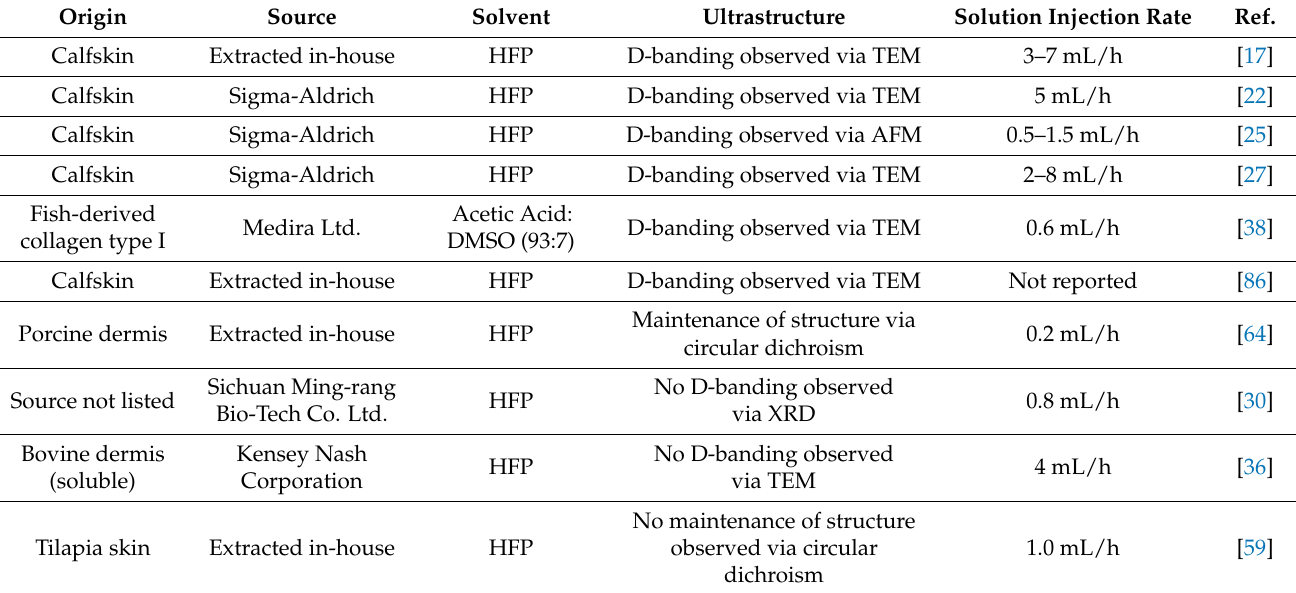
Figure 3. ( A ) SEM image of a scaffold electrospun from calfskin collagen type I solubilized in 1,1,1,3,3,3-hexafluoro-2-propanol (HFP). ( B ) TEM image of an individual electrospun collagen fiber exhibiting D-banding. Modified from [22] with permission. Table 1. Assessment of D-banding in scaffolds electrospun collagen